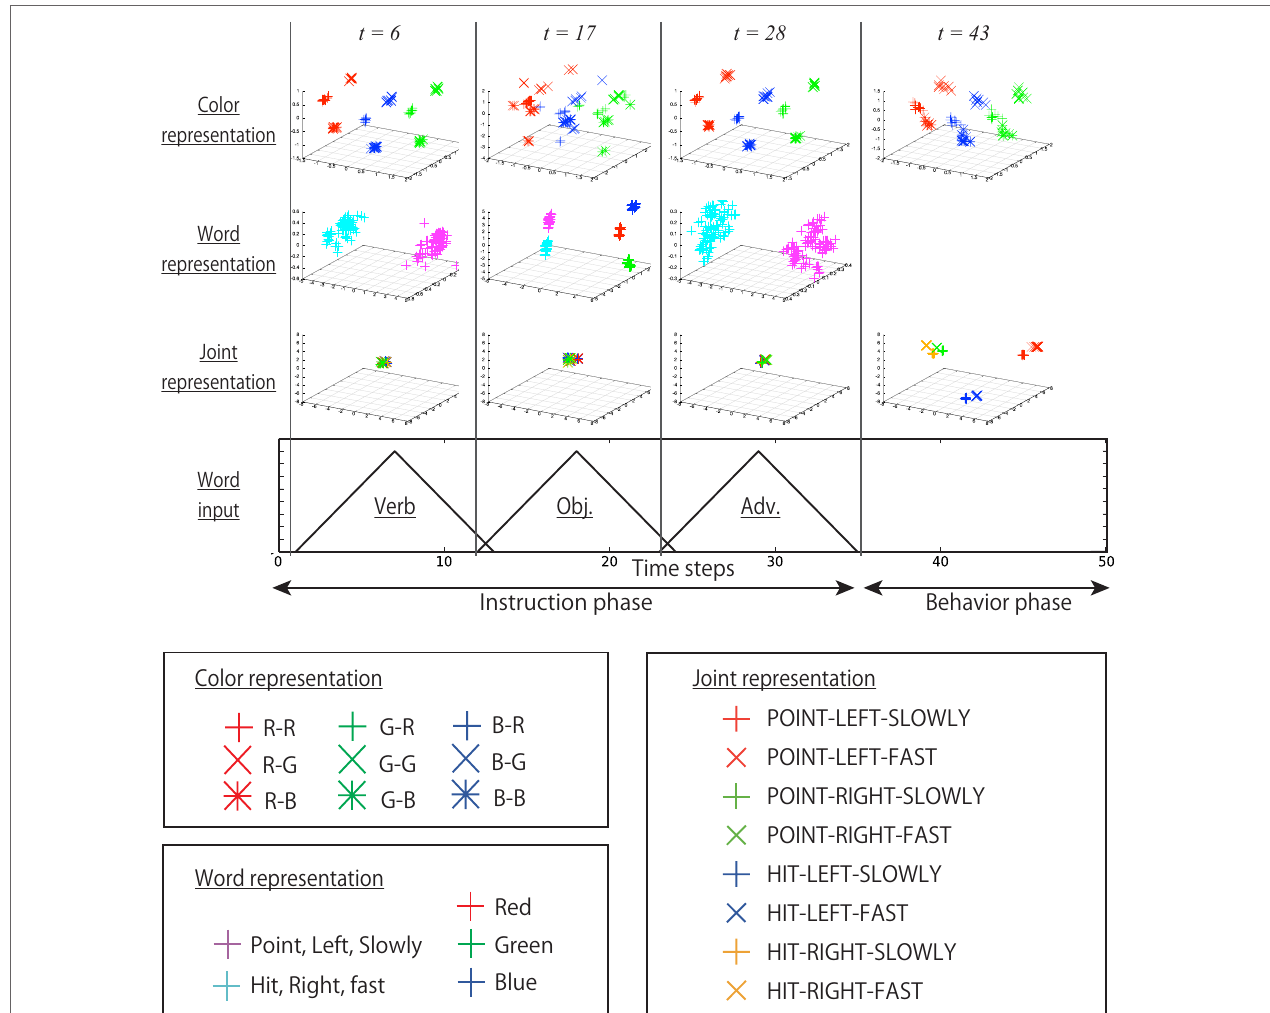
FIGURE 13 | The internal states of the bottom layer at various time steps during interaction episodes projected onto various subspaces: in other words, the static representations . The times t = 6, 17, 28 correspond to the tops of the triangle input of words. The time t = 43 corresponds to the 10th time step after the instruction phase. In the first row, the information about the bell colors is constantly reflected. Note that in the objective phase, the cluster structure is deformed because the integration of bell color and a color word is required. In the space shown in the second row, the cluster structure corresponding to the current word input is shown. In the space of the third row, the information about joint angles is mainly represented.